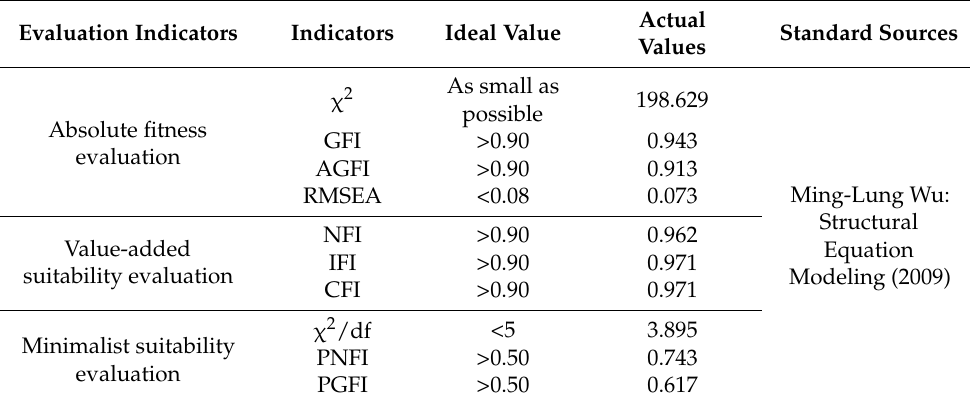
Table 5. Evaluation table of the fitness index of the structural equation